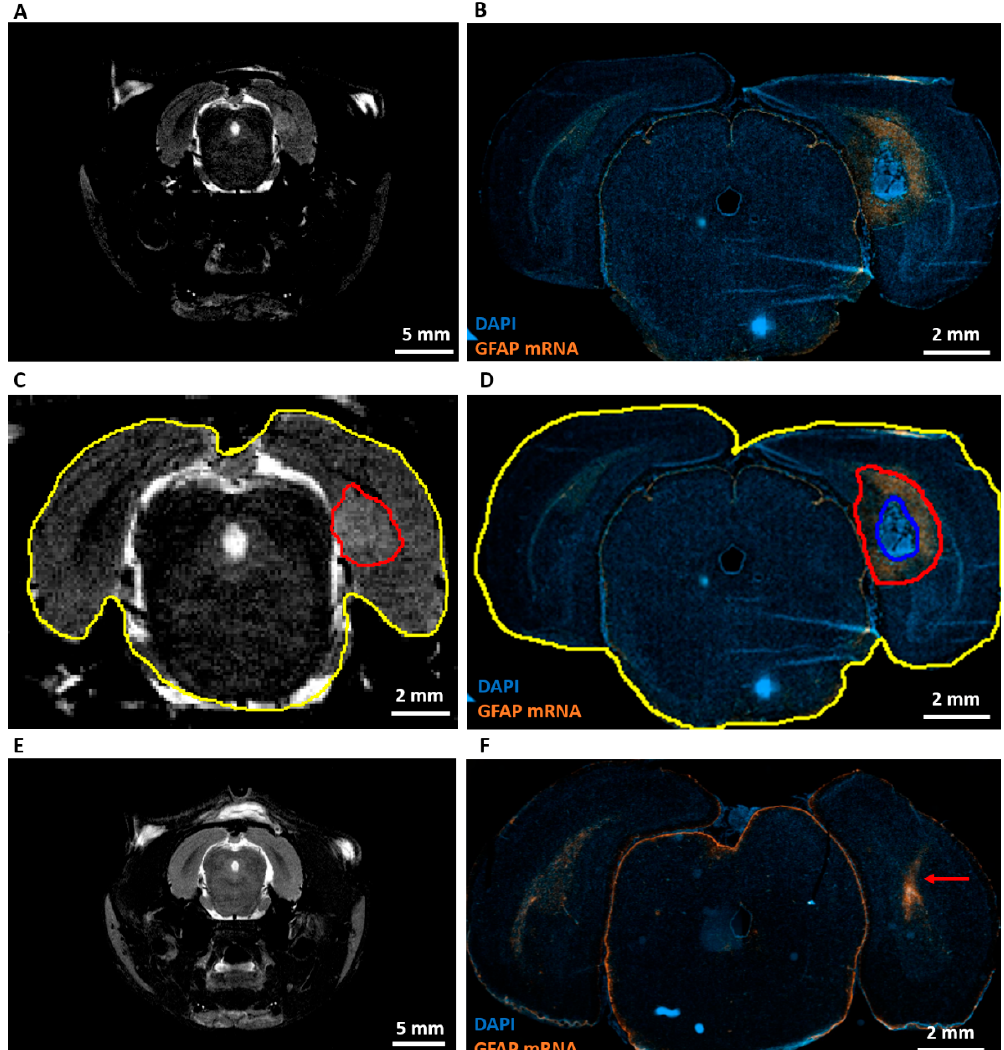
Figure 4. Expression of GFAP mRNA and comparison with MRI. ( A ) Representative T2 MRI image of a GB rat on PID8. A homogeneous hyperintense zone can be identified ipsilateral of the inoculation site. ( B ) Representative RNAscope image of the same GB rat on PID9. This image shows a large tumor (strong DAPI staining) surrounded by high level of GFAP mRNA expression. ( C ) Alignment of the hyperintense zone (red) and whole brain (yellow) on the T2 MRI image of a GB rat on PID8. Relative size of the hyperintense zone is calculated by dividing its area by the total area of the brain slice on MRI. ( D ) Alignment of tumor (blue) and tumor + rim of strong GFAP mRNA expression (red). Relative areas are calculated by dividing the blue and red area by the total area of the brain slice on the RNA scope image (yellow). ( E ) Representative T2 MRI image of a control rat (C4) on PID8. ( F ) Representative RNAscope image of C4 on PID9. The red arrow indicates the injection tract, in which there is an increase in GFAP mRNA expression.